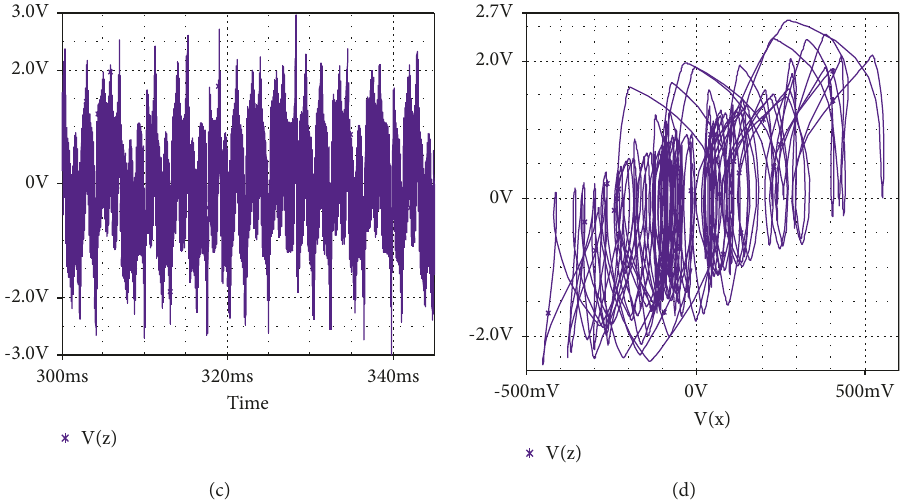
Figure 23: Time series (a), (b), (c), and phase portrait in plant ( z , x ) (d) of bursting phenomena obtained when the amplitude of the sinusoidal load torque is R � 35.2154 kΩ , the frequencies is F � 50Hz , and the rest of parameters are